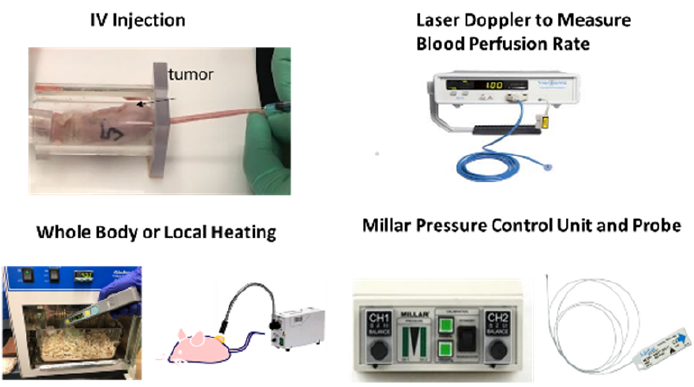
Figure 1. Equipment used in the